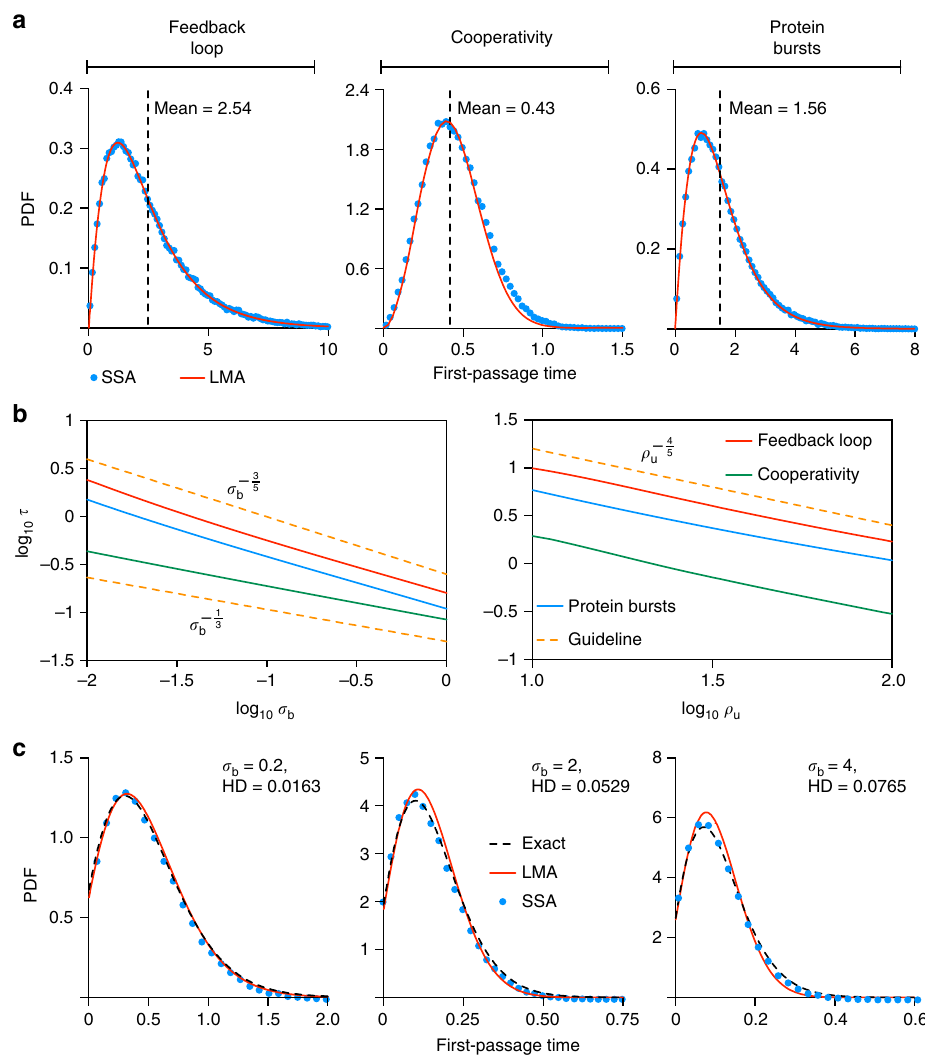
Fig. 7 First-passage time (FPT) analysis of the switching from promoter state G to G * . a Compares the LMA prediction for the FPT probability density function (PDF) with zero proteins in state G initially (red solid line) with that obtained using the SSA (blue dots) for the three non-oscillatory feedback loops. Cooperativity and protein bursts generally reduce the mean FPT. The parameter values are: ρ u = 60, σ b = 0.01, the cooperativity order cp = 2 and the mean protein bursts size b = 2. Note that there is no dependence of the FPT distribution on σ u and ρ b since the fi rst-passage time process stops when the state changes to G * . b Shows that the mean FPT ( τ ) is a power law in two parameters σ b and ρ u . The solid lines are the LMA predictions, while the orange dashed lines are guidelines indicating the power law. c Compares the LMA prediction for the FPT distribution in steady-state conditions (red solid line) with that obtained using the SSA (blue dots) and with the exact solution (Eq. (18) in Supplementary Note 4) for the feedback loop with no cooperativity as a function of σ